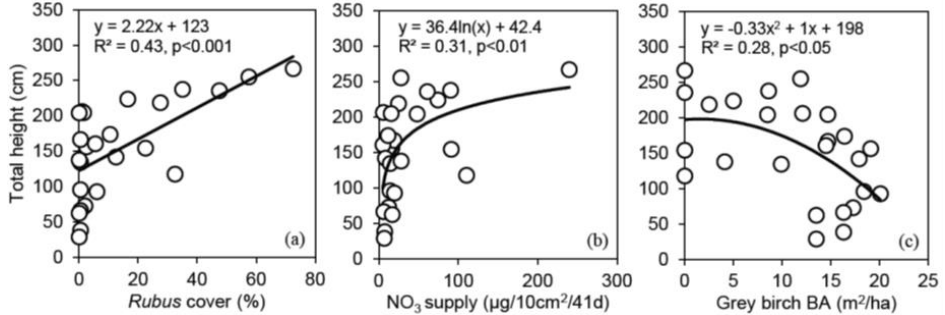
Figure 7. Bitternut hickory ( Carya cordiformis ) total height after 6 years as a function of ( a ) cover of Rubus species in the understory, ( b ) soil NO 3 supply rate and ( c ) the basal area (BA) of grey birch ( Betula populifolia ) in the overstory. N = 25 plots for each relationship.